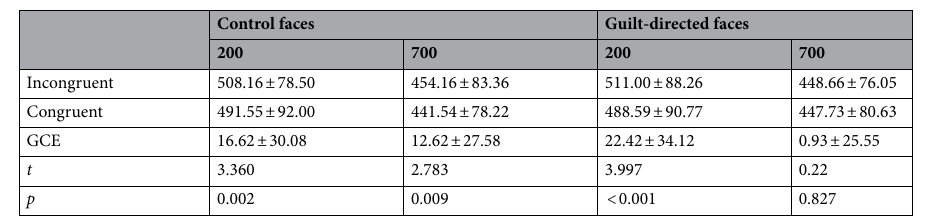
Table 2. Reaction times (M ± SD, ms) for gaze congruency, face type and SOA. GCE = RT incongruent − RT congruent ; The p -values show the results of the post hoc tests comparing RT differences between gaze-congruent and gaze-incongruent